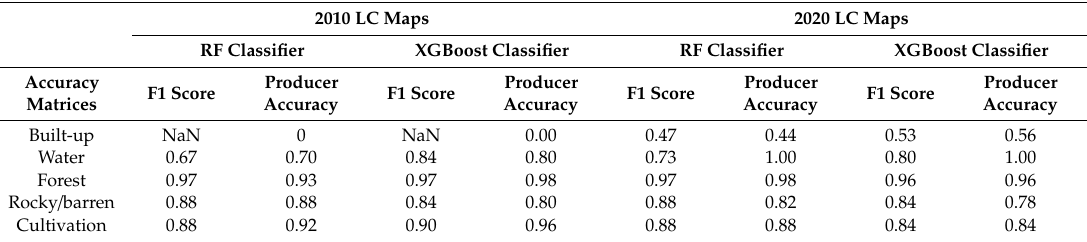
Table 5. F1 score and producer accuracy for Landsat imagery used in the study.